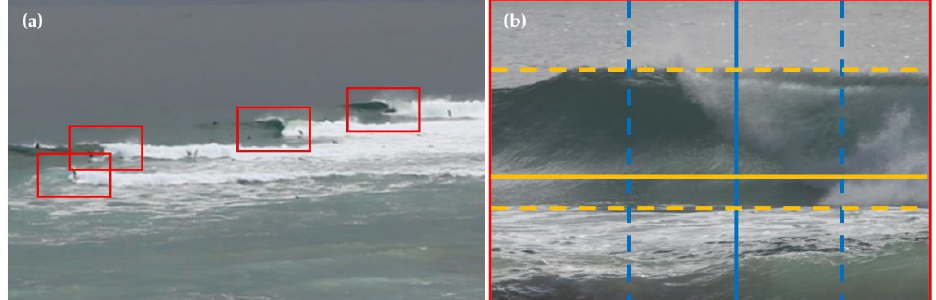
Figure 1. ( a ) Manually annotated wave peel regions at Snapper Rocks, QLD, Australia. ( b ) Precise definition of the wave peel centre for WPT purposes. The vertical centre is defined by the yellow lines; the horizontal centre is defined by the blue lines (photo from Currumbin Beach QLD, Australia).